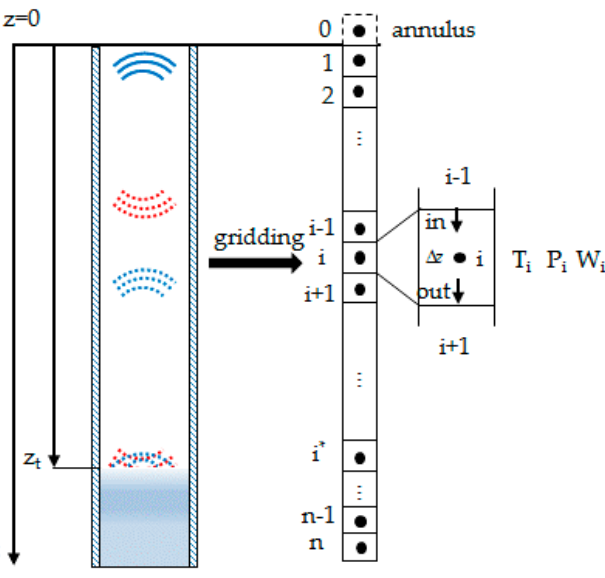
Figure 2. Computational grid of acoustic propagate in annulus.